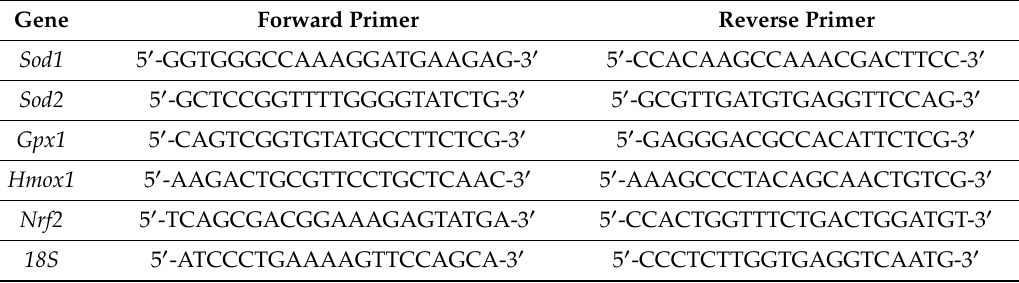
Figure A1. Carbonylated proteins in control and oxidized NPCE cells (15 mM AAPH, 90 min) were measured at 366 nm using the DNPH method. Data are represented by mean ± SD. Table A1. The sequence of primers used in